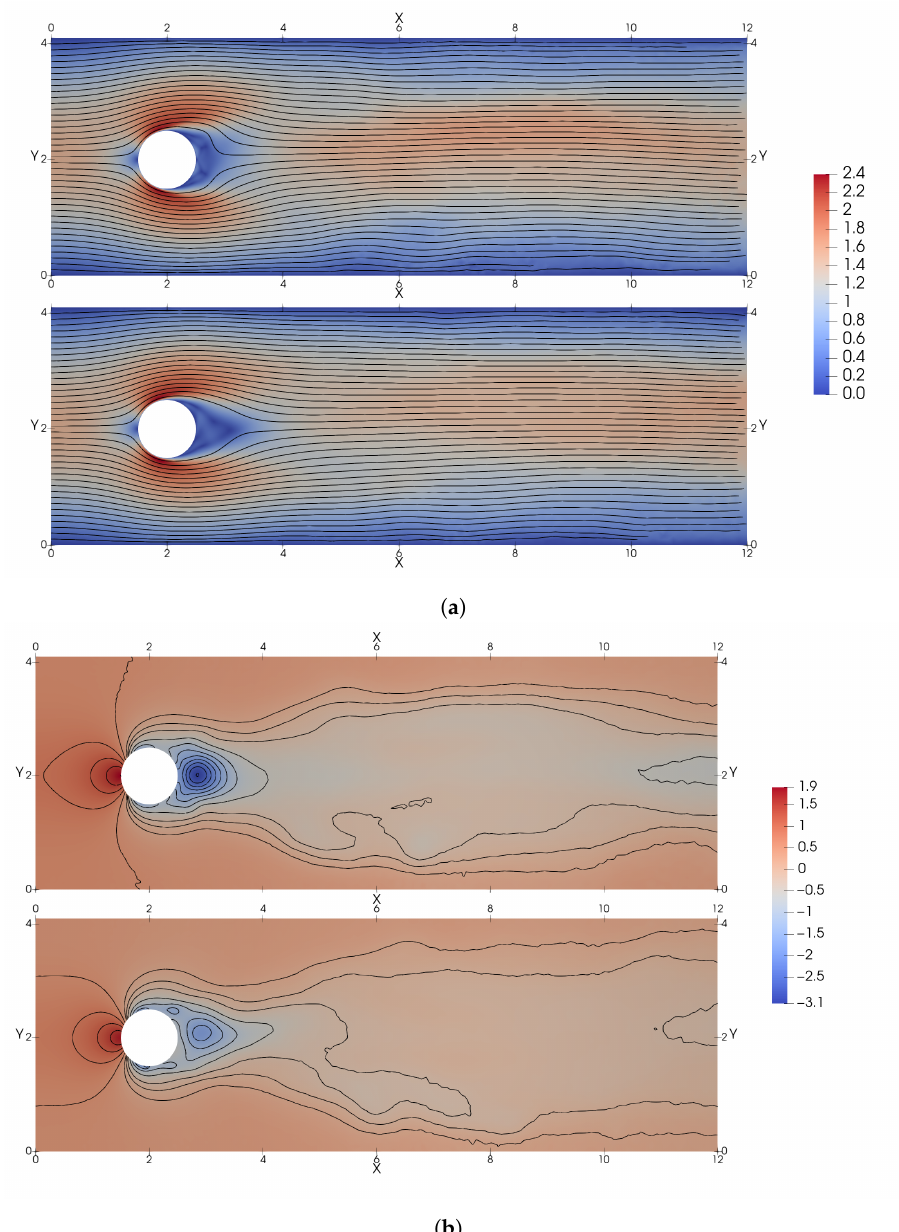
Figure 14. Average flow fields at Re = 2000, where each pair of images, the baseline case without control is depicted on the top and the controlled case is depicted on the bottom. ( a ) Average magnitude of velocity fields. ( b ) Average pressure